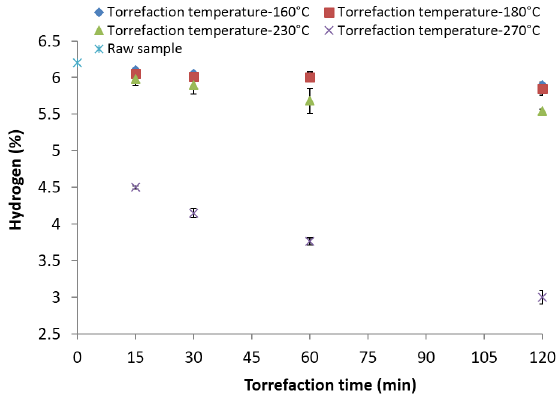
Figure 9. Hydrogen content in the lodgepole pine biomass with respect to the torrefaction time and temperature.